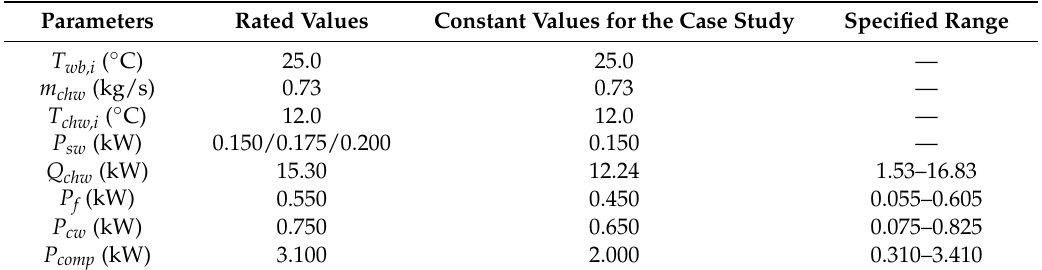
Table 5. The specifications of the system and operating conditions for the considered case.